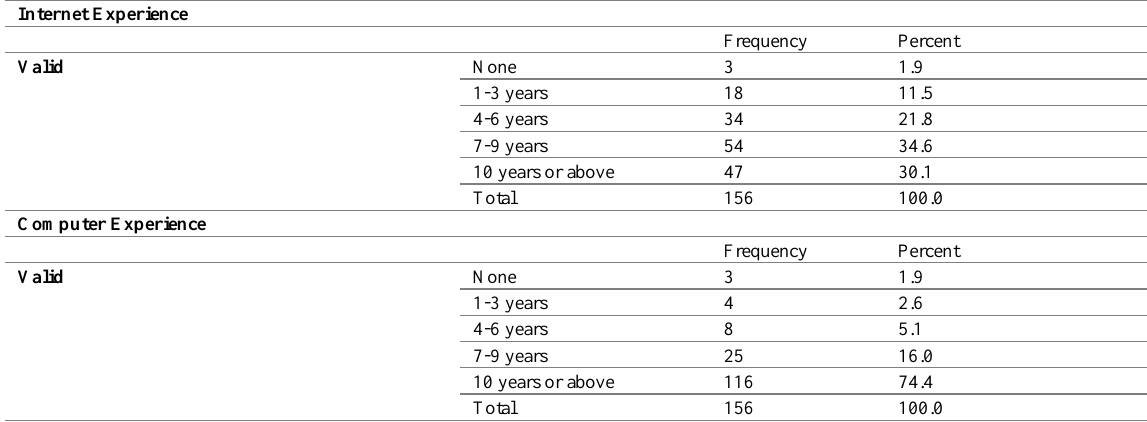
Table 3: Computer and Internet experience of the